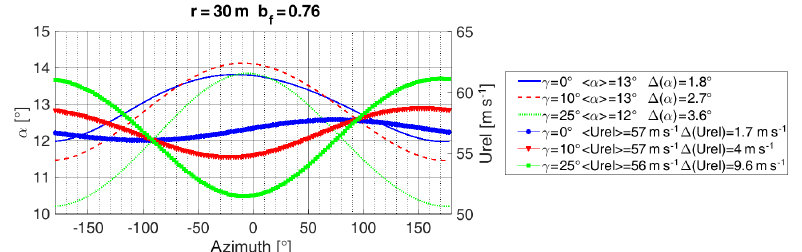
Figure 2. α (lines with no markers) and U rel (lines with markers) calculated by the simplified analytical model as a function of ψ for the 75% blade-span station under yaw misalignments ( γ ) as shown in the legend; U hub = 12ms − 1 . In the legend, the <> and (cid:49) denote mean and range (max–min) of the